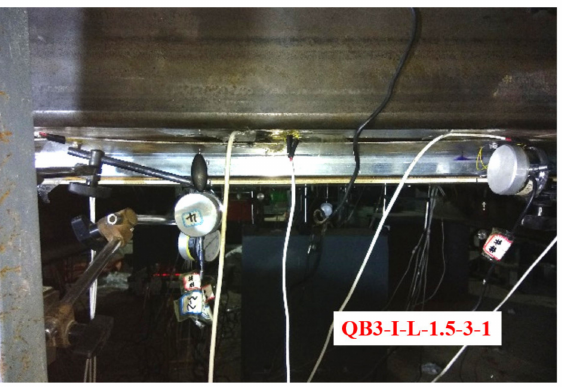
Figure 11. Deformation of continuous L-shaped connectors in the width direction.